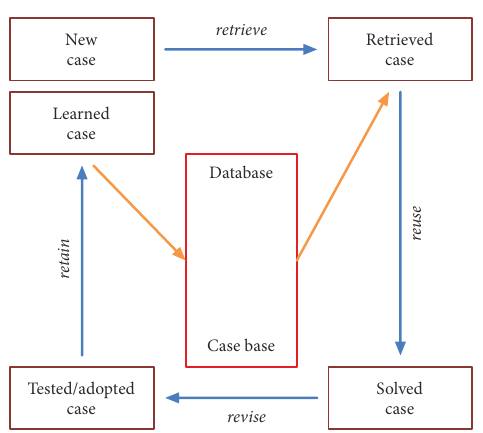
Figure 5. Proposed FCBR CSM workflow (own